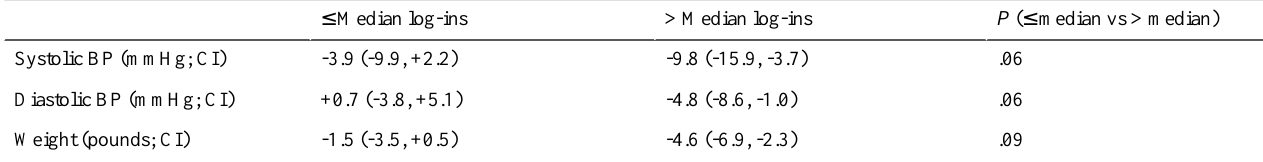
Table 5. Comparison of changes in weight and blood pressure in relation to number of DASH website log-ins (median log-ins for blood pressure group was 50; median for weight group was